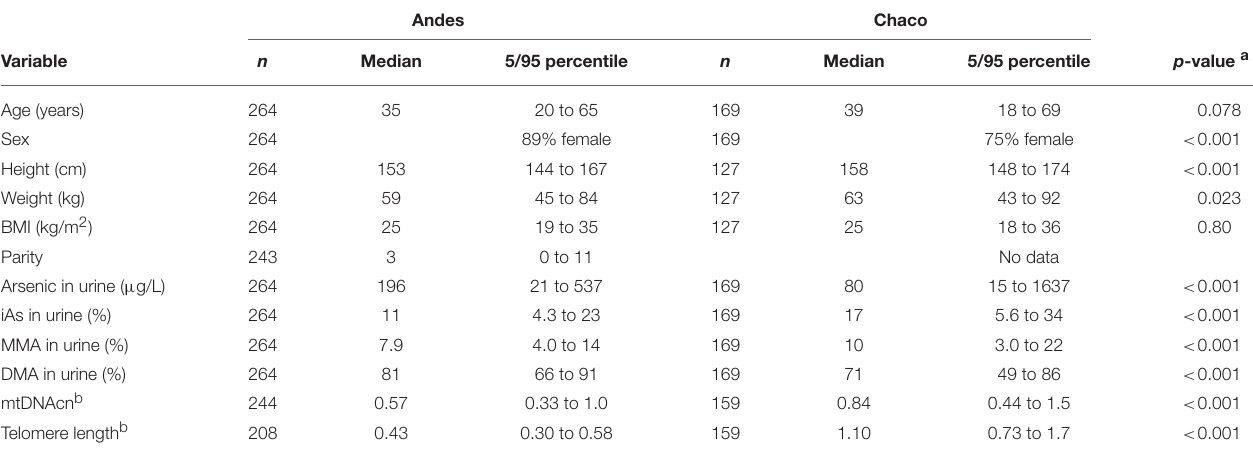
TABLE 1 | Characteristics of the Andes and Chaco study groups. Andes